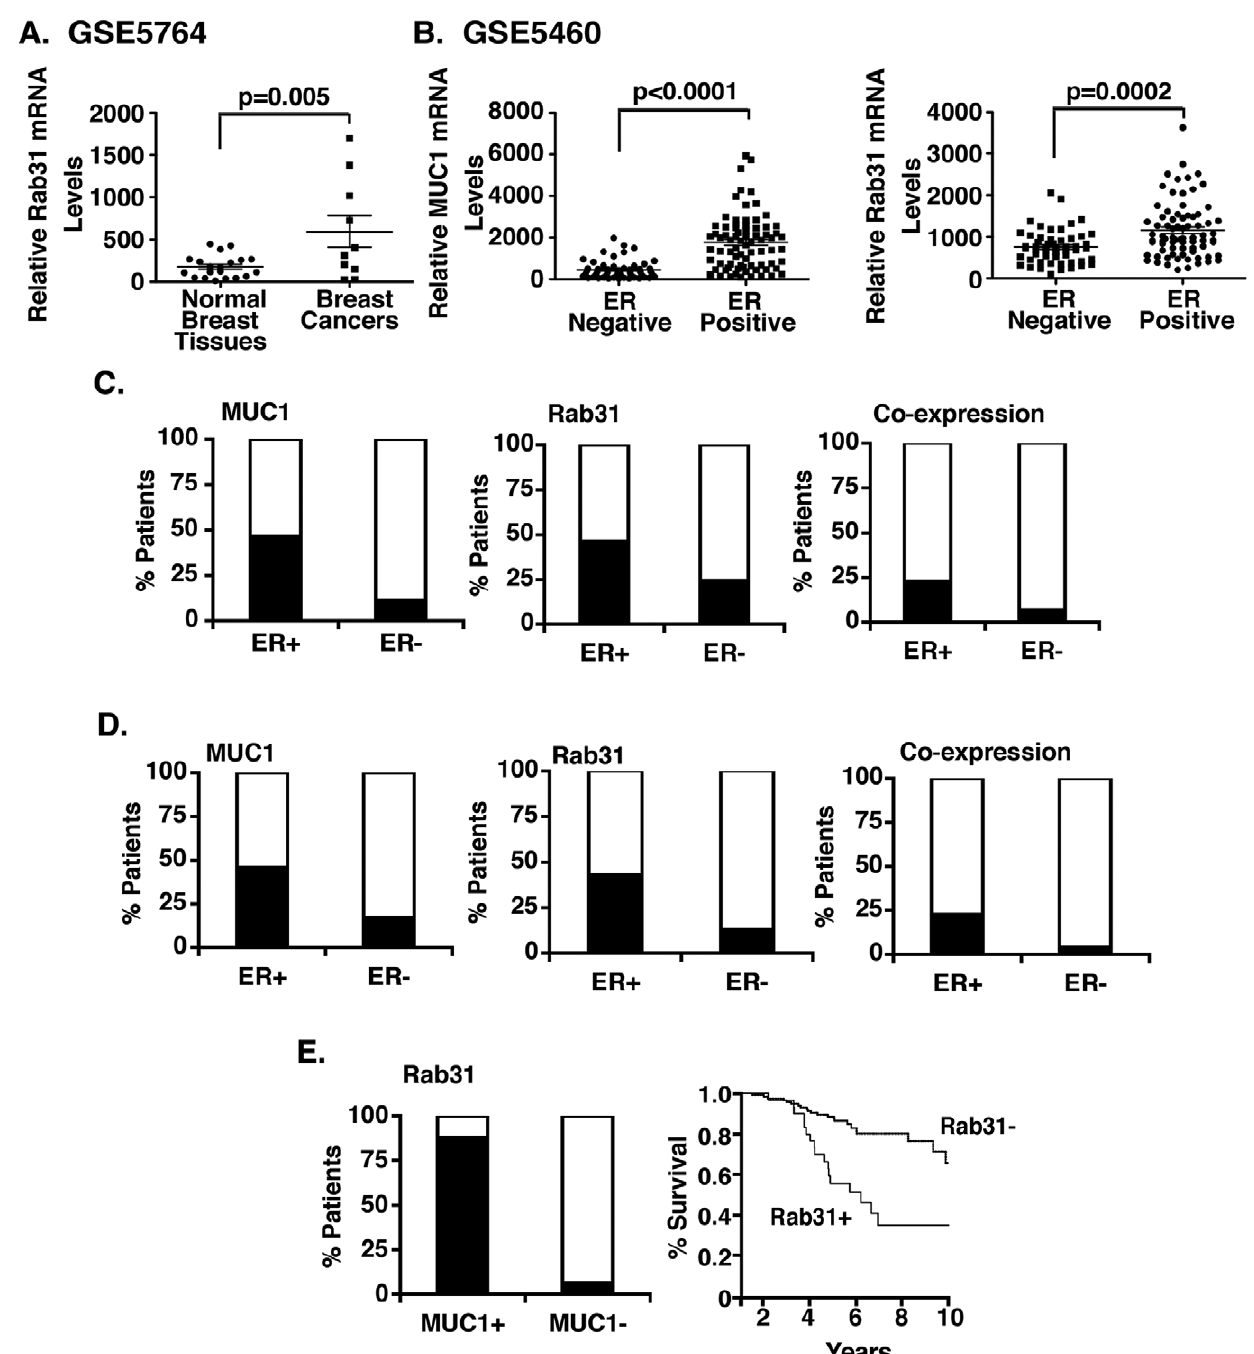
Figure 7. Expression of Rab31 in human breast cancers. A. Analysis of Rab31 mRNA levels in the GSE5764 dataset from 23 normal breast tissues and 10 breast tumors. The results are expressed as the relative Rab31 mRNA levels based on the normalization values in the dataset. B. Analysis of MUC1 mRNA (left) and Rab31 mRNA (right) levels in the GSE5460 dataset from 76 ER + and 53 ER 2 breast tumors. Normalized microarray data were separated into ER + and ER- groups. C and D. Analysis of MUC1 mRNA (left), Rab31 mRNA (middle) and co-expression levels (right) in the Loi dataset (C, 262 ER + and 45 ER 2 breast tumors) and van de Vijver dataset (D, 226 ER + and 69 ER 2 breast tumors). E. Analysis of Rab31 and MUC1 mRNA co-expression levels in 147 ER + breast tumors (left). Percentage overall survival for patients with Rab31-positive versus Rab31-negative breast tumors (right; Chanrion dataset). doi:10.1371/journal.pone.0039432.g007 secondary antibodies and enhanced chemiluminescence (Amer- gy), anti-MUC1-C (Ab5; Neomarkers), anti-ER a , anti-EGFR (Santa Cruz Biotechnology) and anti- b -actin (Sigma). Immune sham Biosciences). complexes were detected with horseradish peroxidase-conjugated